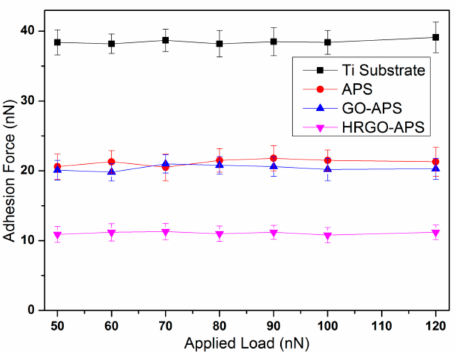
Figure 10. Variation of the adhesion force of Ti substrate and prepared coatings with the change of applied load (with scanning rate of 2